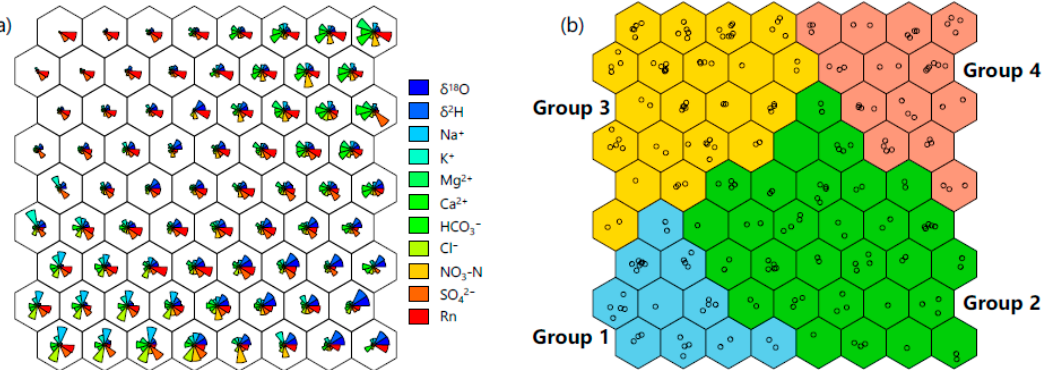
Figure 11. ( a ) All reference vectors in each of the 72 nodes and ( b ) classification of the self-organizing map (SOM) nodes into four groups. The circles on each map hexagon represent the groundwater samples assigned to that node.